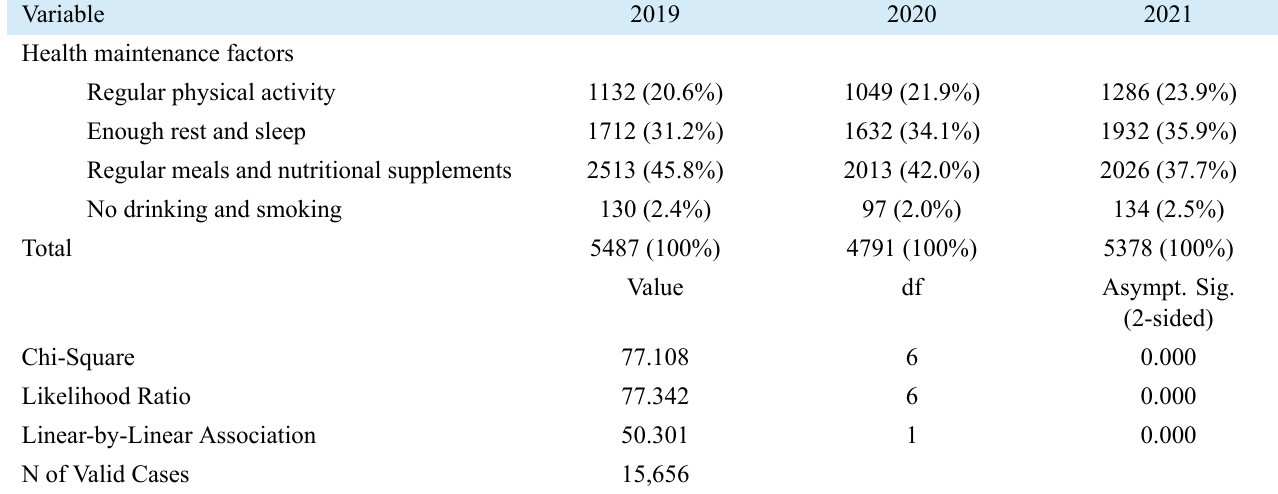
TABLE 5. Changes in health maintenance factors by year (2019–2021).